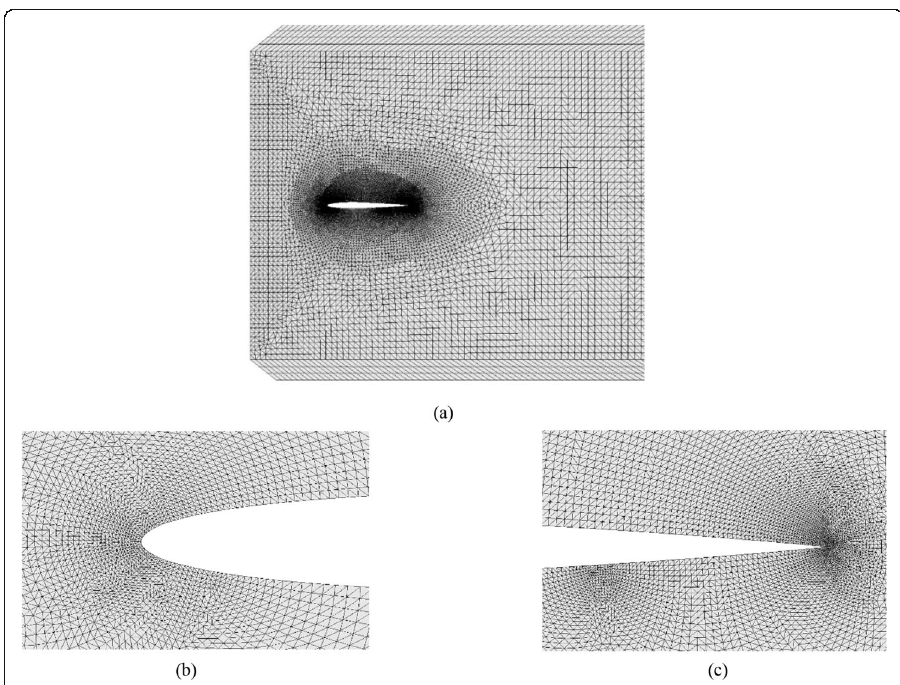
Fig. 24 Diagram of the detailed mesh of a 3-D wing configuration with suction and injection slots